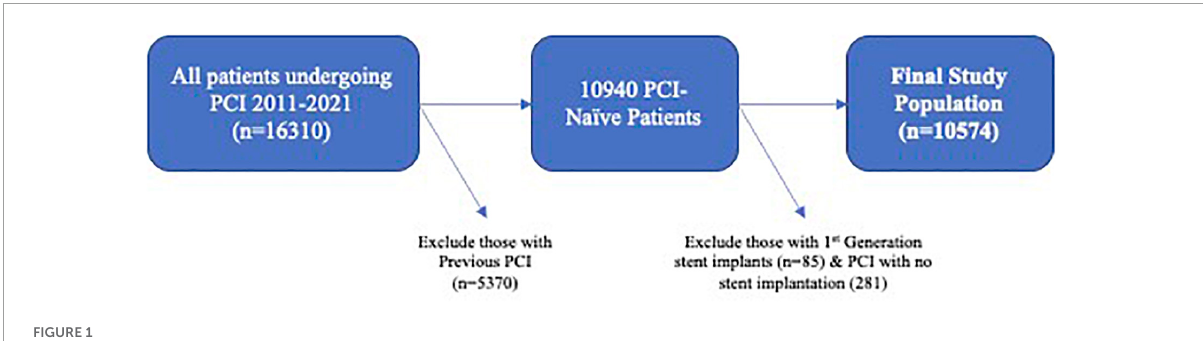
FIGURE1 Study flow-chart.